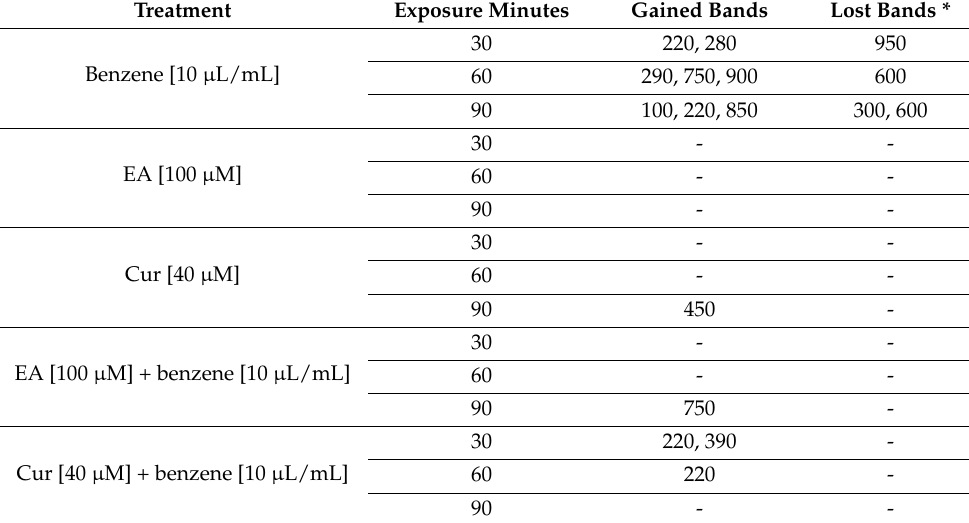
Table 1. Molecular sizes (bp) of appeared and disappeared bands after amplification with primer 6 in zebrafish blood cells DNA exposed to different substances. EA: ellagic acid; Cur: curcumin. Treatment Exposure Minutes Gained Bands Lost Bands